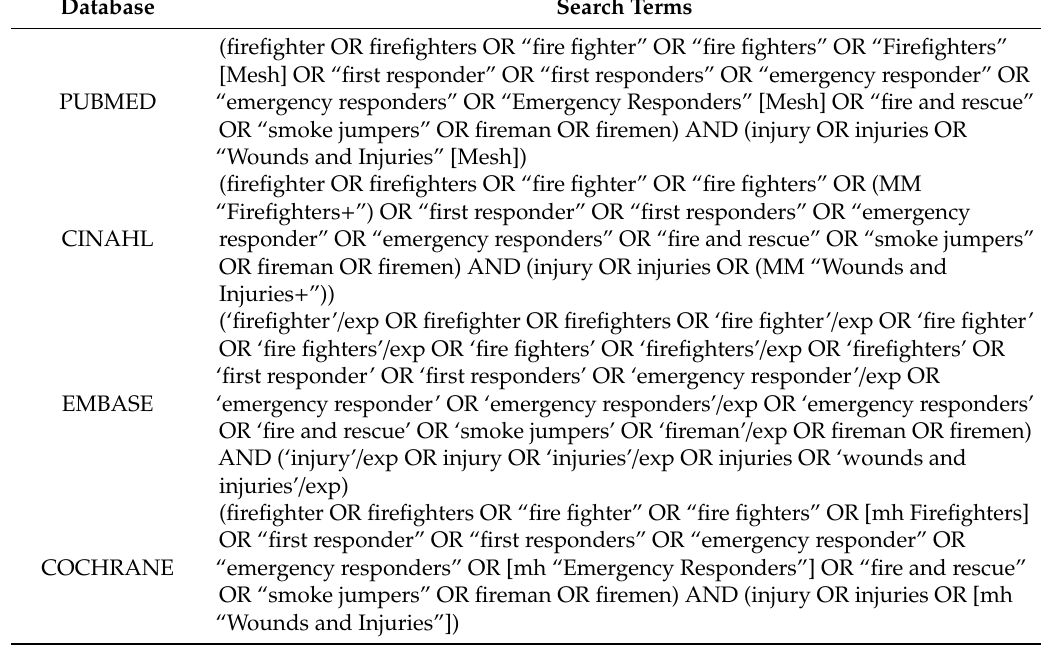
Table 1. Details of literature search: databases used and search terms (completed on 08 July